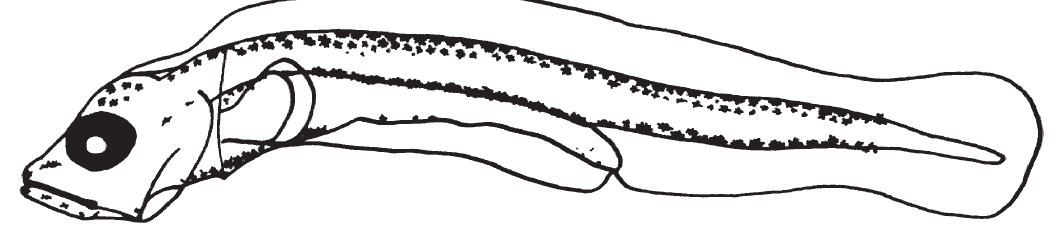
- Body depth at the inferior part of the cleithrum.